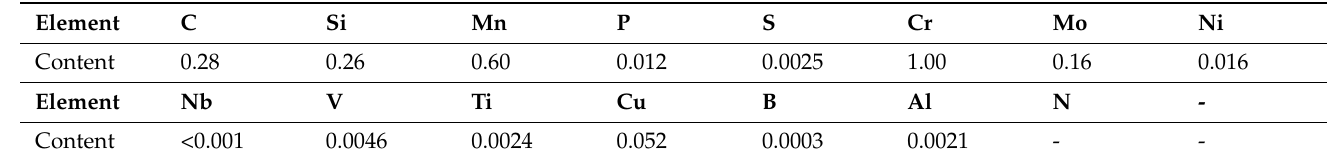
Table 2. Chemical composition of P110